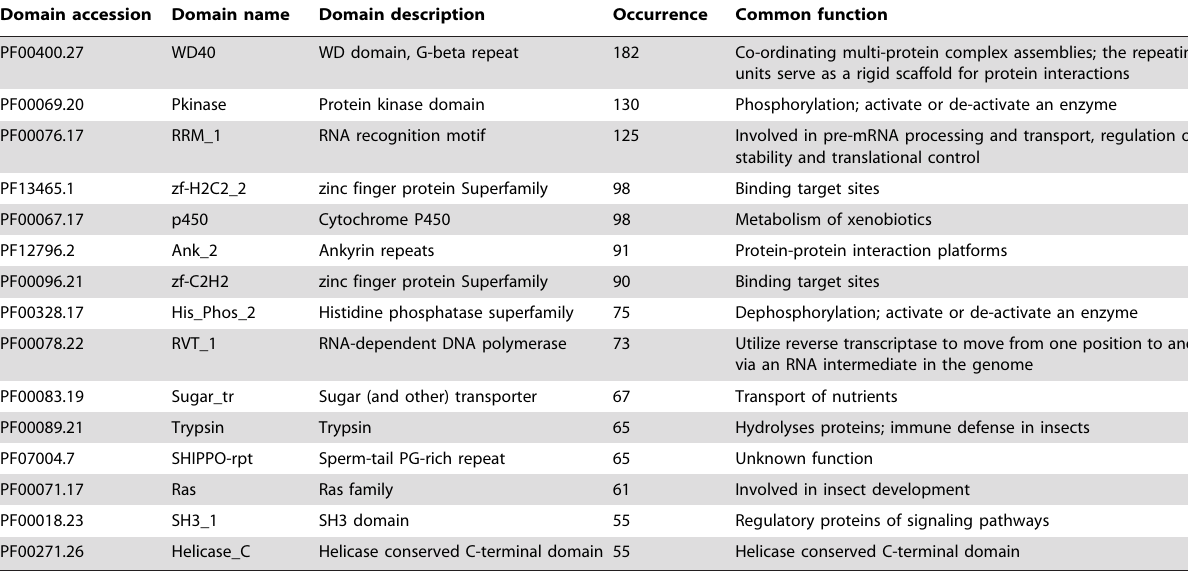
Table 3. Summary of top 15 domains predicted in S. endius transcripts.